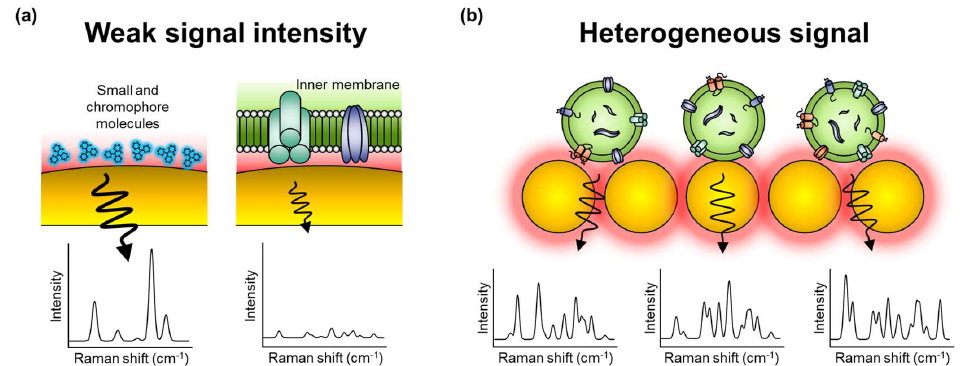
Figure 2. Challenges in label-free SERS of EVs. ( a ) The intrinsic SERS signal of EVs is extremely weak in intensity than in small molecules with the chromophore. ( b ) The difference in binding status and complex composition of EVs in biological samples results in fluctuations in the signal pattern.